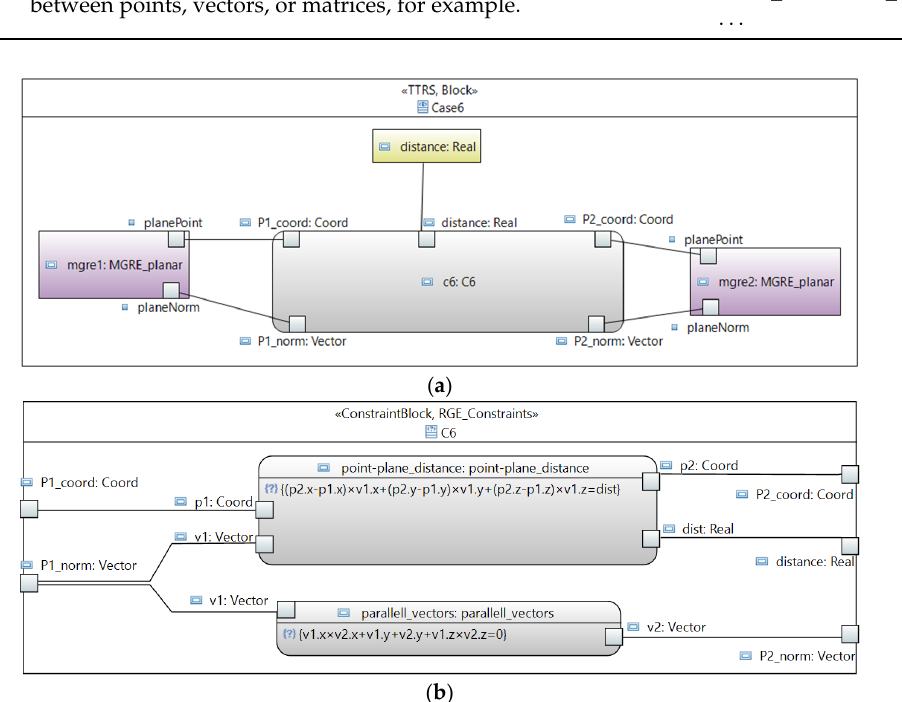
Figure 10. Diagrams related to TTRS Case6: ( a ) PAR of TTRS block Case6 «TTRS» block (planar parallelism); ( b ) PAR of the C6.